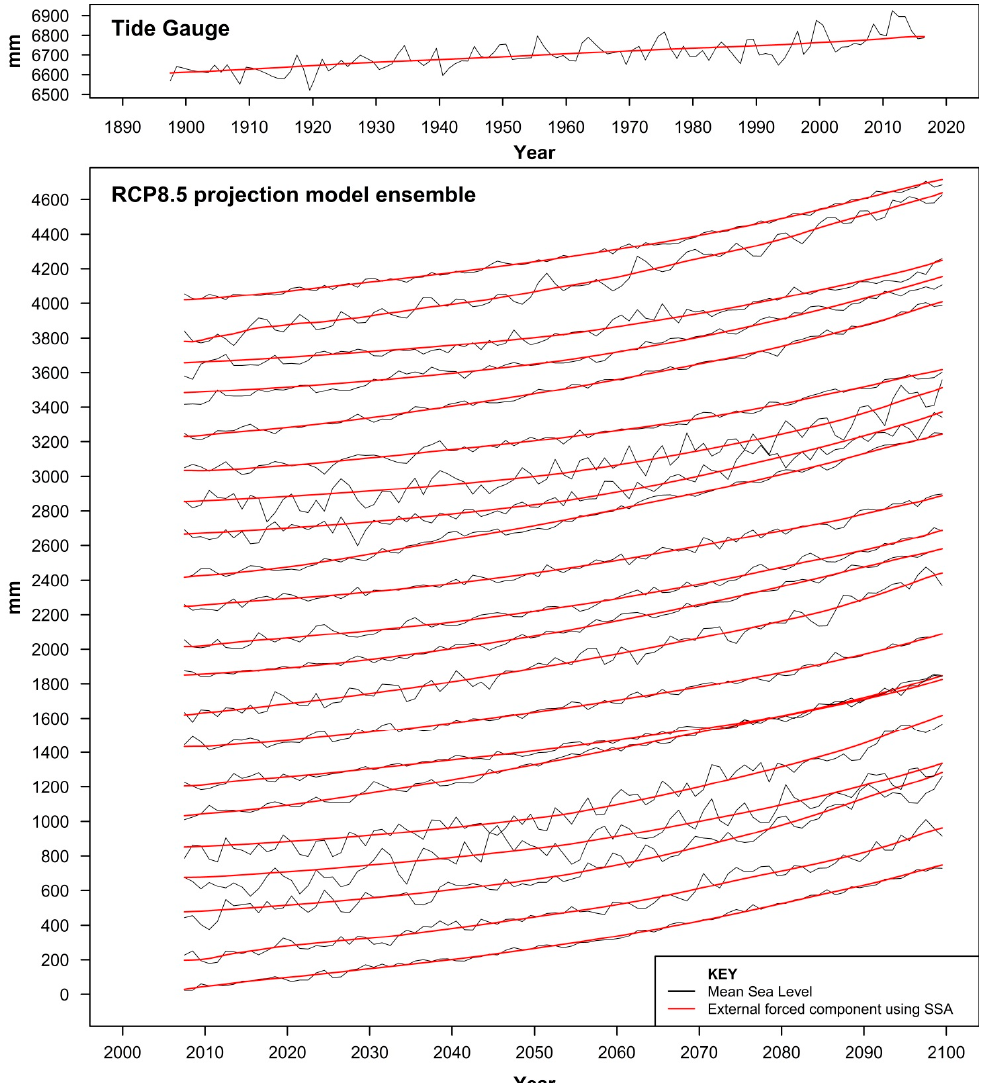
Figure 2. Optimization of singular spectrum analysis (SSA) to isolate the external forced component of both the tide-gauge records and projection-model ensemble. The example from Fremantle, Australia, shows the decomposition of the tide-gauge record in the top panel and all 21 representative concentration pathway (RCP) 8.5 projection-model outputs in the bottom panel. Each time series has been notionally offset vertically in the bottom panel by 200 mm for clarity.